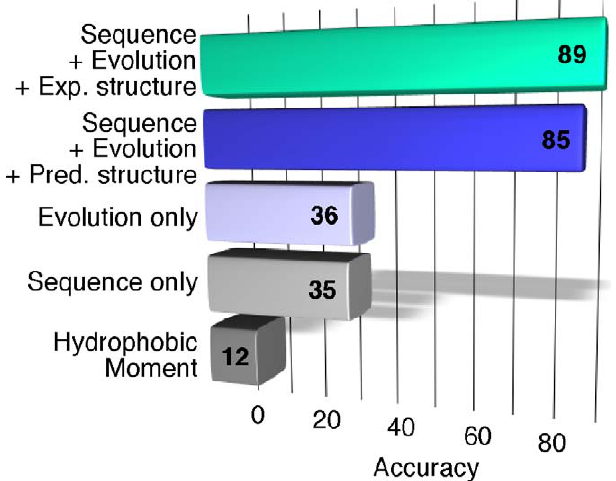
Figure 4. Accuracy of Prediction of Hotspots at Coverage Levels of 15% Several approaches were introduced in the past for the prediction of interface residues. We applied methods that rely on different features to the task of predicting hotspots (to which none of them was optimized). The hydrophobic moment method represented the approach that relies exclusively on local physicochemical factors. The evolutionary approach was represented by the ET method, which relies on conservation to identify functionally important residues. A knowledge-based tool we introduced in the past represented the sequence-only approach. Finally, ProMate, a method for predicting interaction sites from unbound structures, represented the structure-based approach.